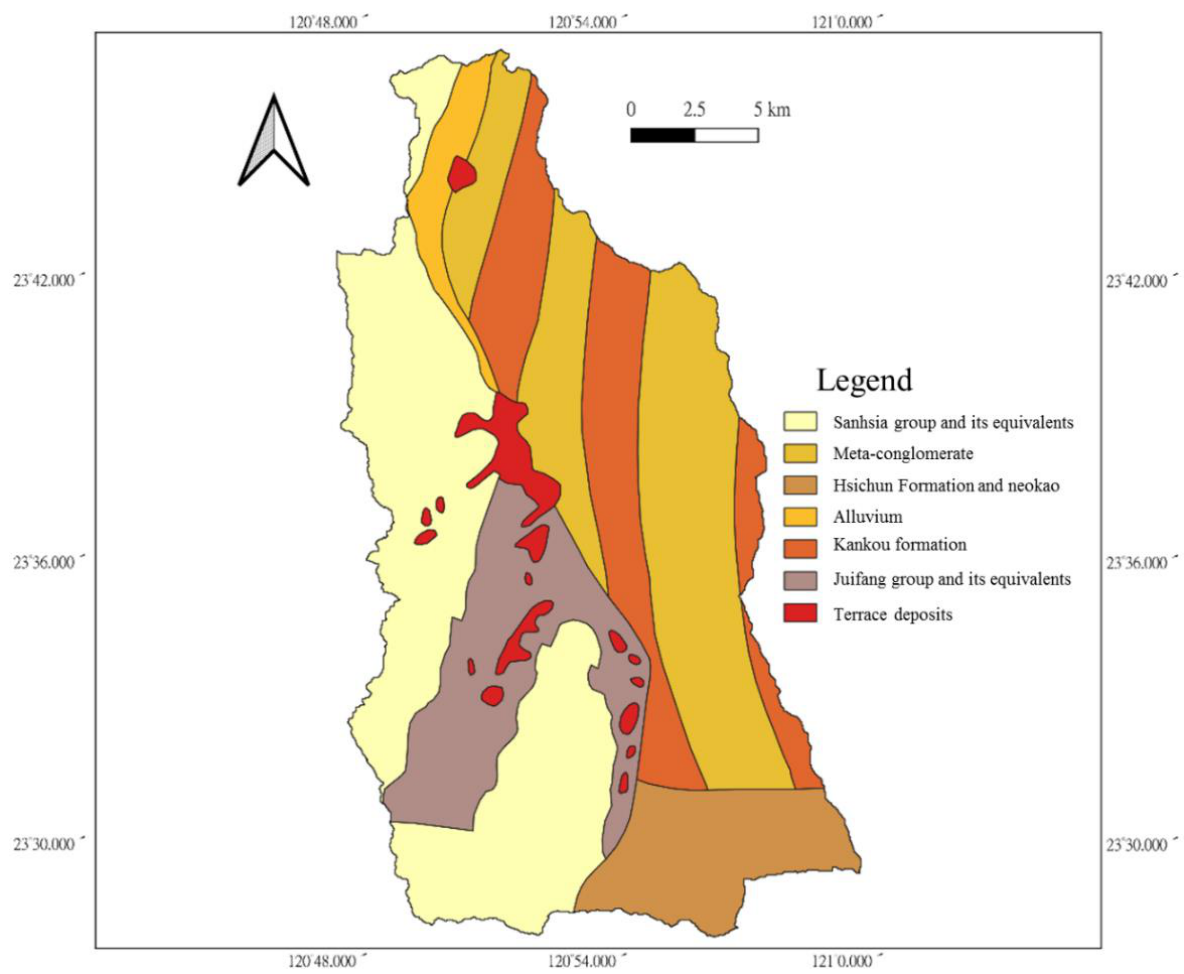
Figure 2. Stratigraphic distribution map of the Chenyoulan watershed.